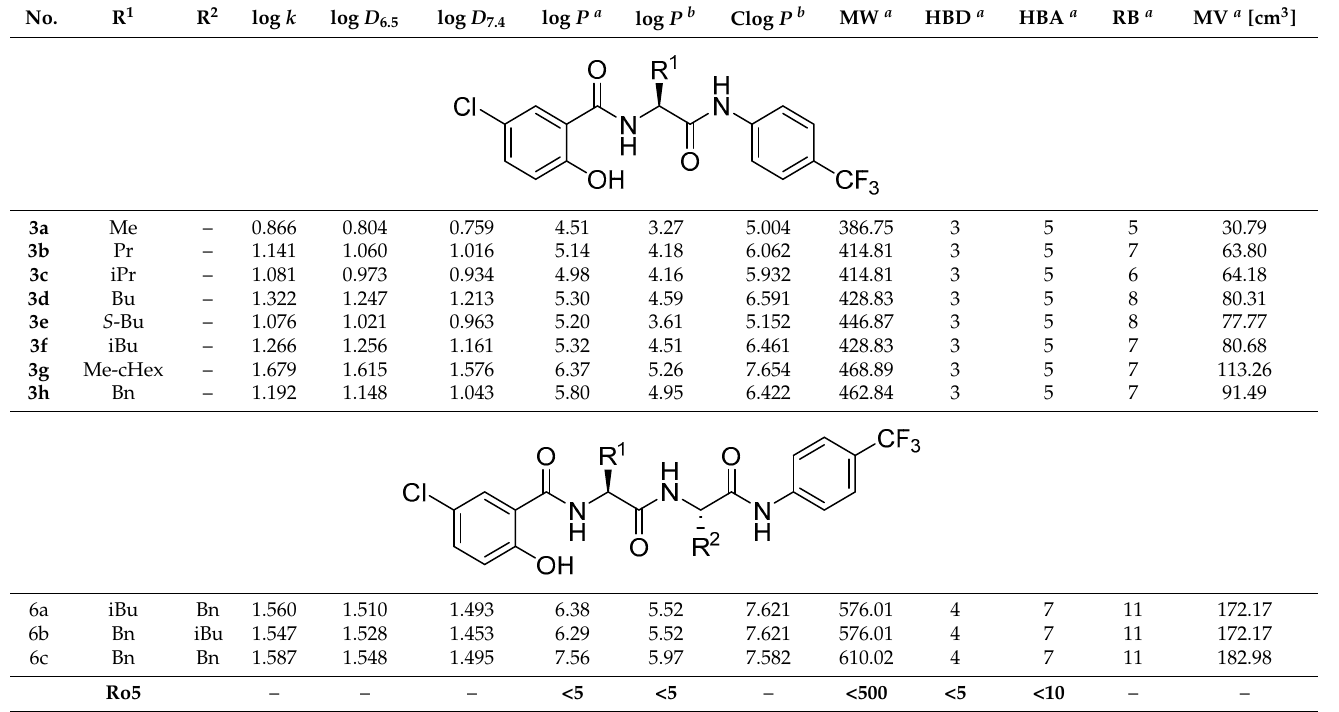
Table 1. Structures of diamides 3a – h and triamides 6a – c , experimentally determined (log k , log D 6.5 , log D 7.4 ) and calculated (log P /Clog P ) lipophilicity values of the final compounds, as well as